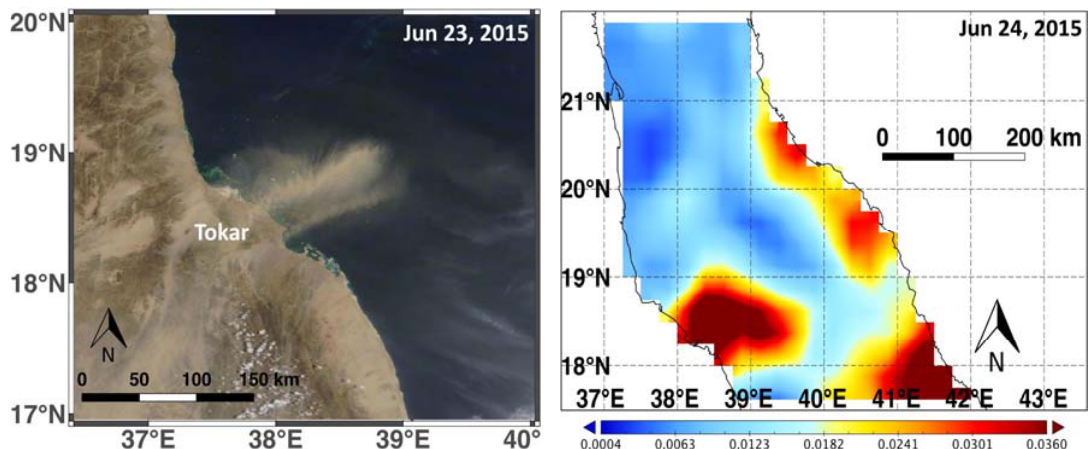
Figure 7. The Tokar Wind Jet represented by ( Left) MODIS-Terra true-color composite image of a dust event induced by the Jet on 23 June 2015 and ( Right) Advanced Scatterometer (ASCAT) Level 3 wind field stress (pascal) on 24 June 2015.